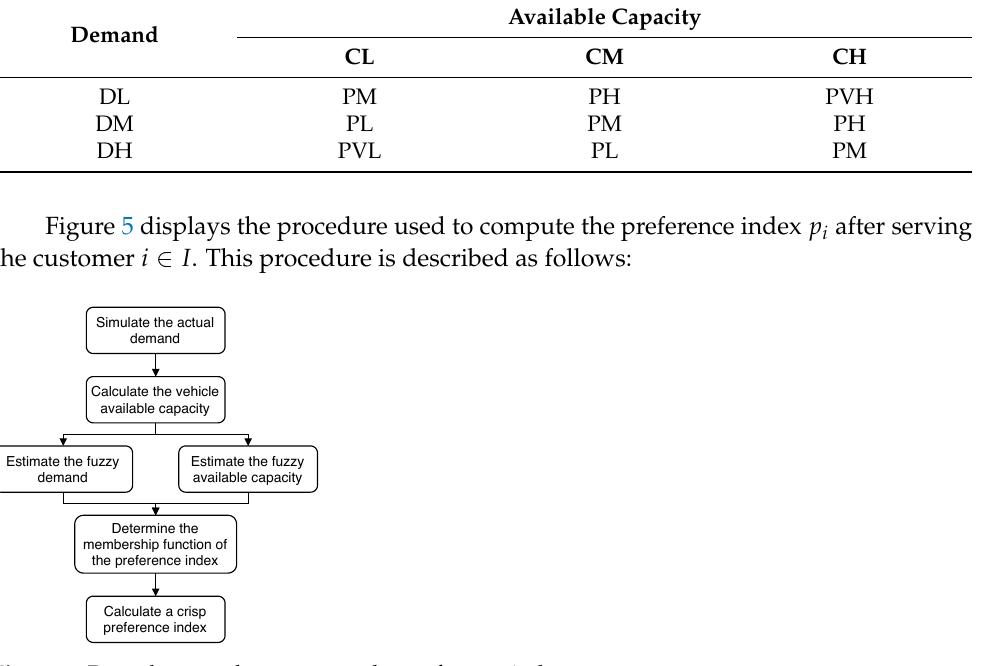
Figure 5. Procedure used to compute the preference index p i .